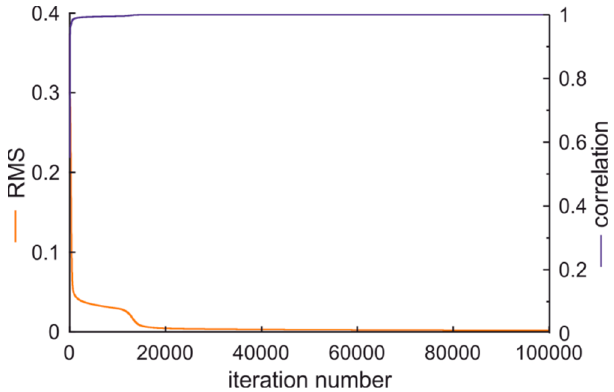
Figure 17. The ANN learning process of fuel state classification.